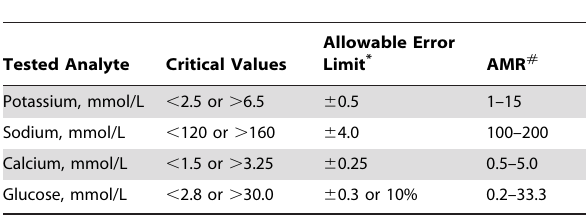
Table 1. Critical Values, Allowable Error Limits, and